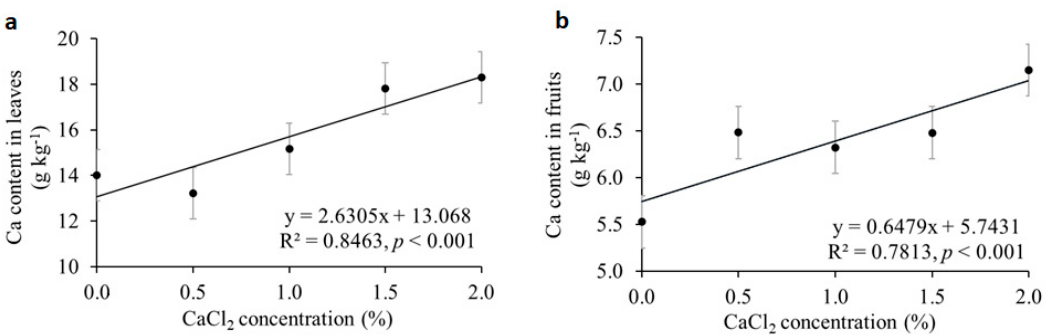
Figure 1. Calcium concentration in leaves ( a ) and fruits ( b ) of fig tree cv. ‘Roxo de Valinhos’ as a function of different concentrations of pre-harvest CaCl 2 spray. Bars in each column symbolise standard errors (n = 4).